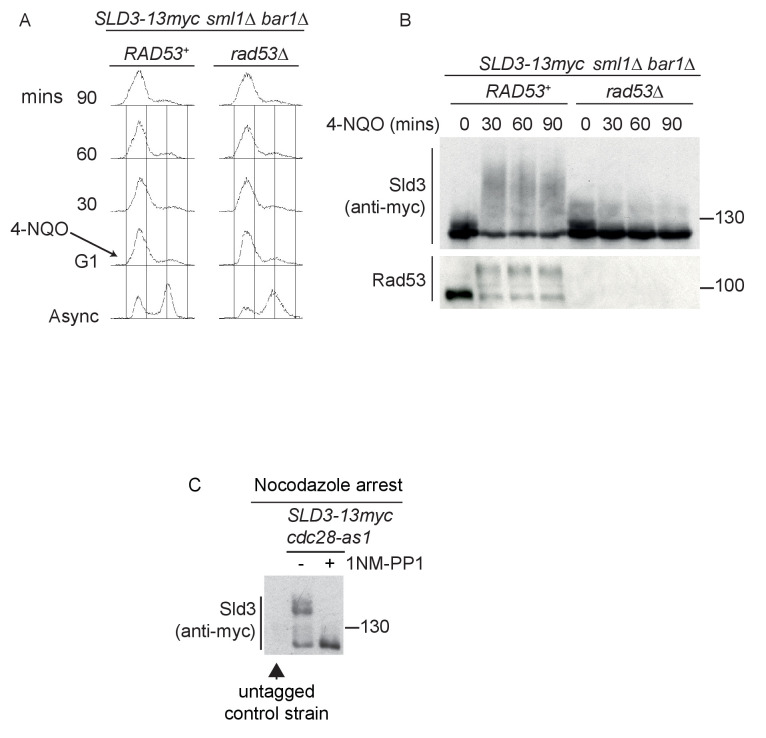
Sld3 phosphorylation in G1 phase after DNA damage is Rad53 dependent.(A) Flow cytometry of strains arrested in G1 phase with the mating pheromone alpha factor. Strains were held in G1 phase, with the addition of 10 μg/ml 4-NQO for the indicated times. All strains are bar1∆ to maintain G1 arrest and also sml1∆. (B) Western blot of Sld3 and Rad53 phosphorylation from the experiment outlined in (A). Sld3 was resolved on a phos-tag sodium dodecyl sulfate–polyacrylamide gel electrophoresis gel. (C) Western blot of Sld3 from cells arrested in G2/M with nocodazole. These strains contain the cdc28-as1 allele that is inhibited by the addition of the ATP analogue 1-NM-PP1. As Cdc28 is the only catalytic CDK subunit in yeast, the addition of 1-NM-PP1 inhibits CDK activity, revealing that the lower mobility Sld3 band is CDK dependent. The first lane contains untagged Sld3, showing that all bands in this blot correspond to Sld3-13myc.